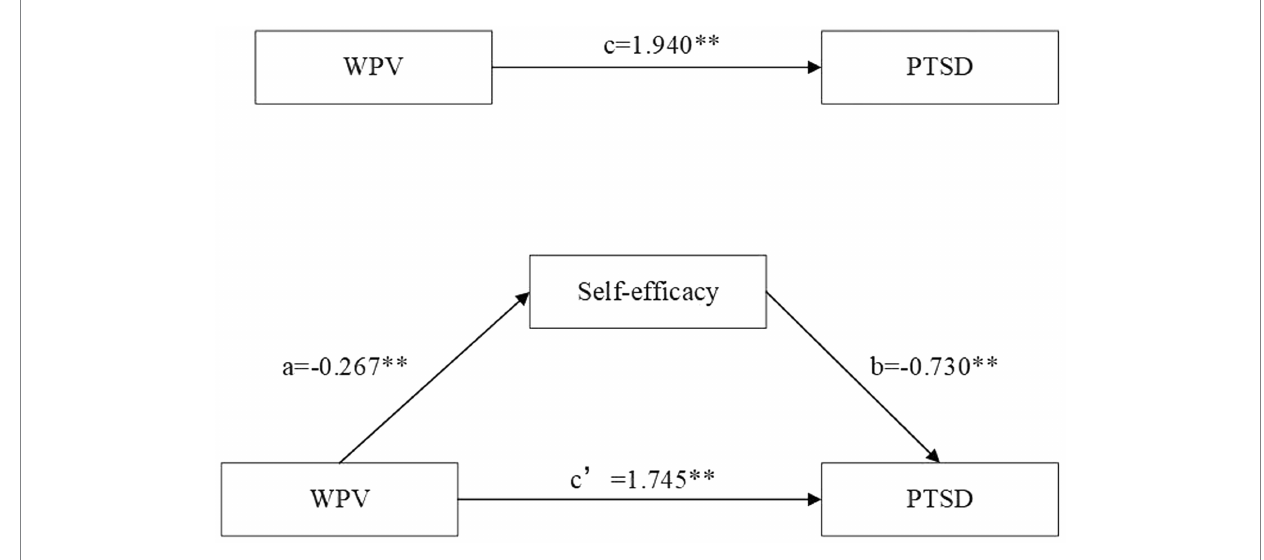
FIGURE 1 Model of the mediating role of self-efficacy between WPV and PTSD. ** p <